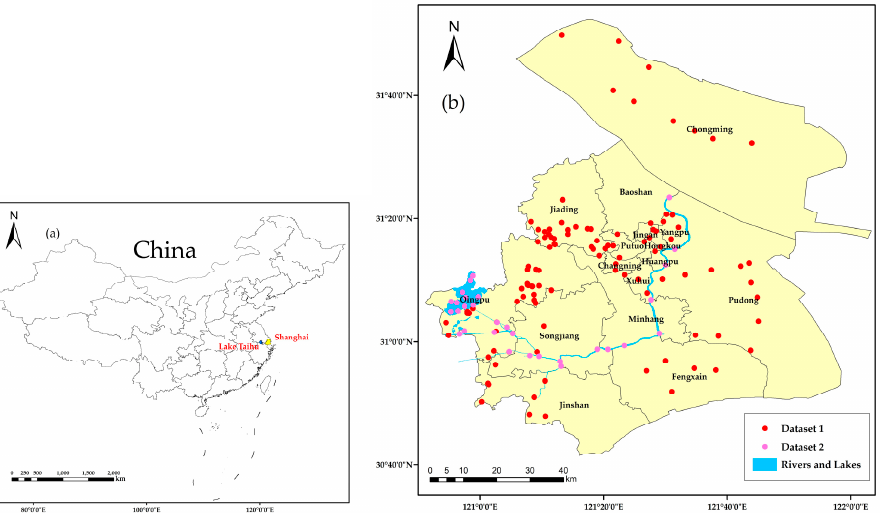
Figure 1. ( a ) Spatial distributions of Shanghai and Taihu Lake in China. ( b ) Study area and in situ sample distribution in Shanghai.